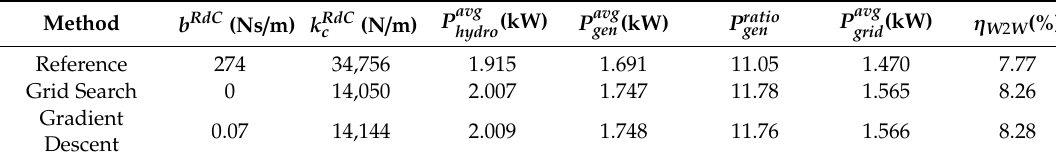
Table 5. Summarized Real Damping Controller